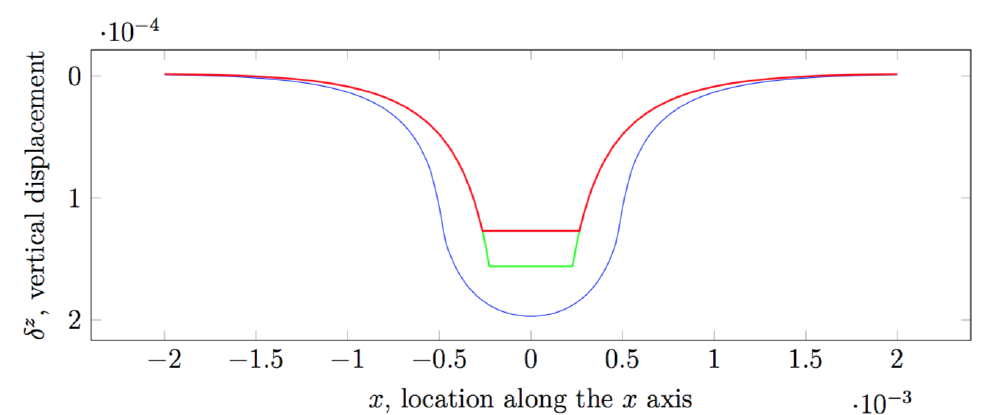
Figure 6. Comparison between Boussinesq–Cerruti’s solution with exact computation of χ ( x ) in red and Ψ ( x ) = 0.25 in green, and Love’s solution in blue for the same contact situation, with a pressure load p = 1 × 10 5 Pa over a cell of 2 a = 1 × 2 b = 0.4 mm, force load F z = p × 2 a × 2 b = 0.04 N, shown along y =